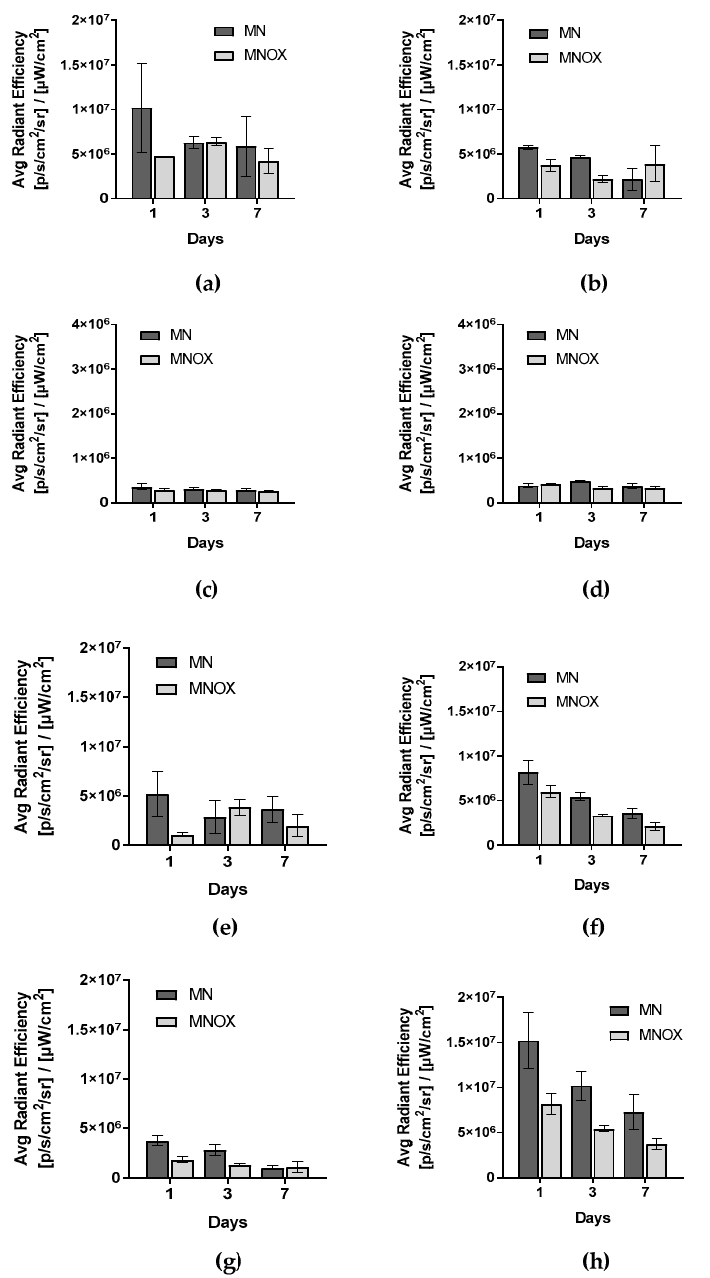
Figure 4. Figure 5. Quantification of ex vivo fluorescence signals. The fluorescence signal was quantified for ( a ) SLNs, ( b ) axillary lymph nodes on tumor sites, ( c ) axillary lymph nodes on non- tumor sites, ( d ) inguinal lymph nodes on non-tumor sites, ( e ) tumors, ( f ) kidneys, ( g ) spleens and ( h ) livers. Fluorescent signal is represented as the average radiant efficiency (mean ± SD). The multiple one-tailed t-test was used for statistical evaluation (n = 9 for MN and n = 9 for